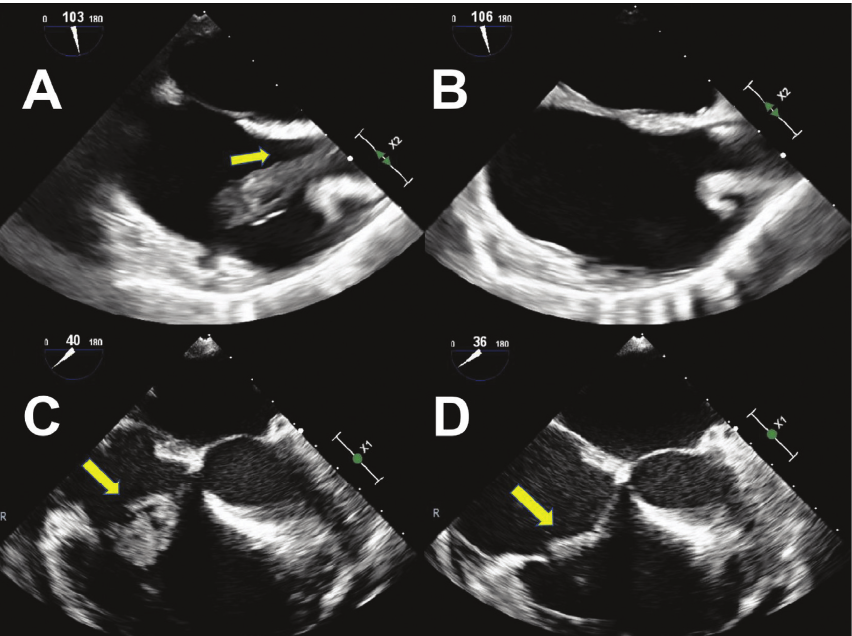
Figure 2: Pre- and postprocedural transesophageal echocardiographic imaging of the removal of large thrombi via AngioVac. (a, c) Large vegetation across the mitral valve. (b, d) Near removal of multisegmented vegetation. There is good intraoperative